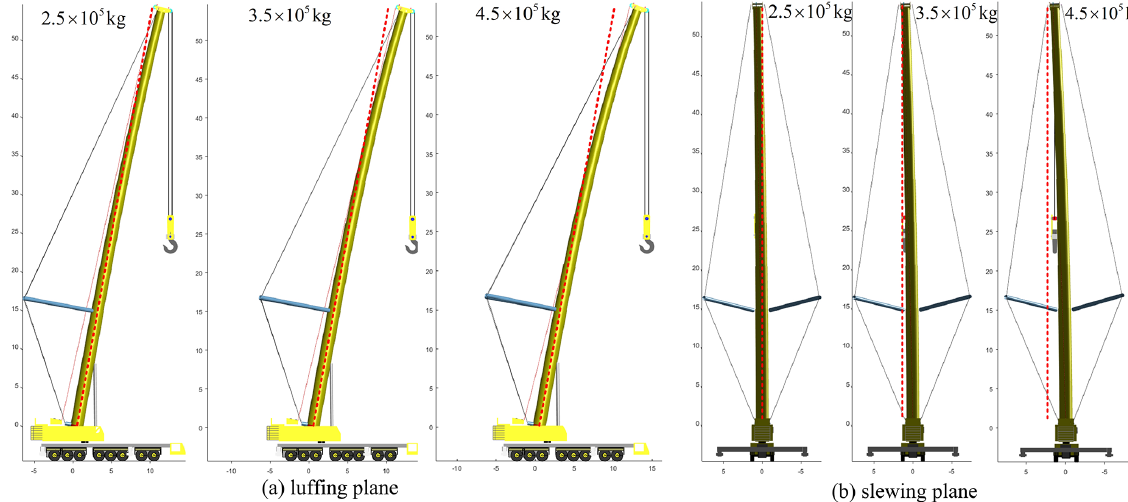
Figure 19. Telescopic boom deformation in the luffing plane and slewing plane.